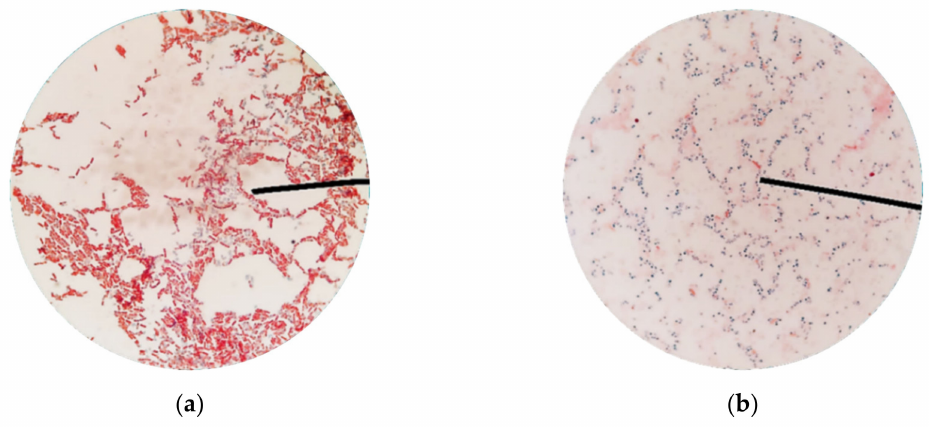
Figure A1. Schae ff er-Fulton stains under an optical microscope: ( a ) directly from an agar plate; ( b ) from the spore suspensions.